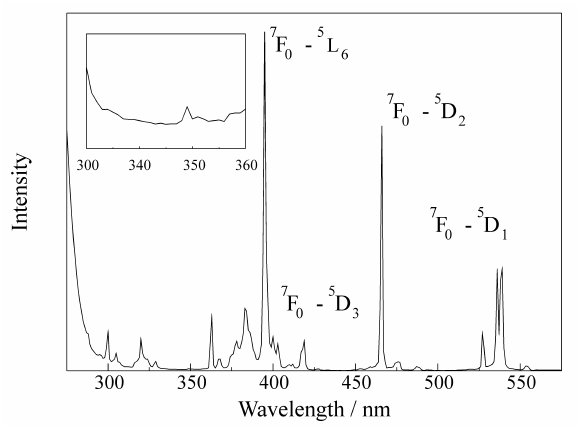
Figure 2. Excitation spectrum of the Y 0.85 Eu 0.15 NbO 4 at room tempera- ture ( l emis = 612